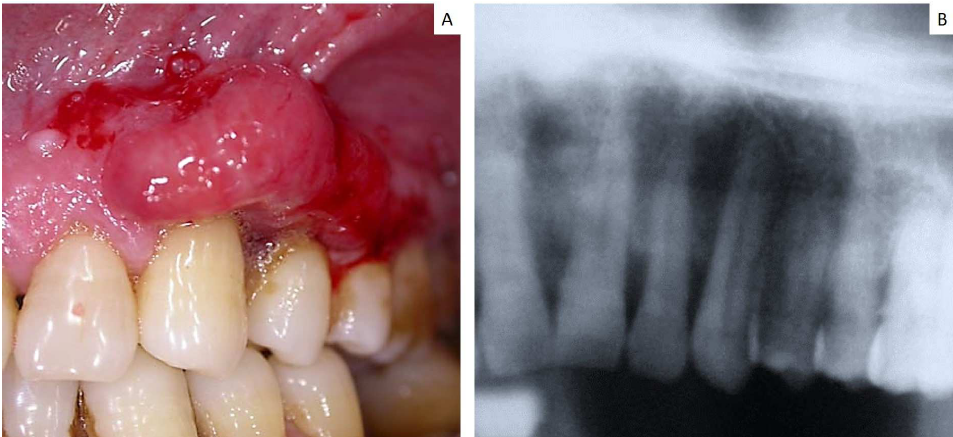
Figure 3. Gingival reddish enlargement involving the 3.2, 3.3 and 3.4 ( A ) with alveolar bone involve- ment, ( B ) mimicking a periodontal lesion but unresponsive to the conventional procedure of dental hygiene and full mouth disinfection, thus needing a biopsy sampling; the histological diagnosis revealed it as the first manifestation of an unknown adenocarcinoma of pulmonary origin.